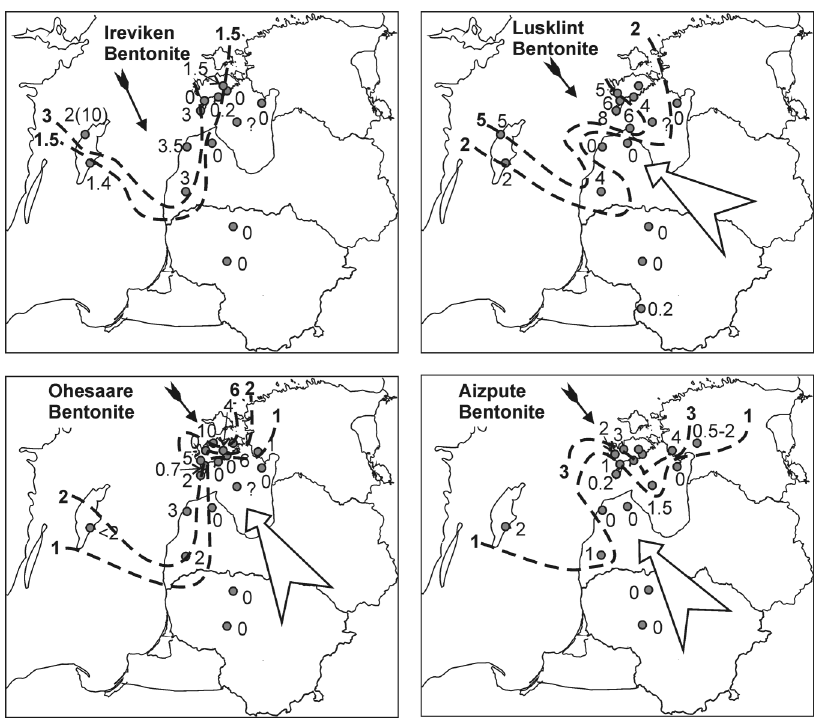
Fig. 5. Distribution maps of the four bentonites from the Sheinwoodian (lower Wenlock). Details of the distribution in Estonia and names and numbers of all drill cores can be found in Kiipli et al. (2008b, 2008d,